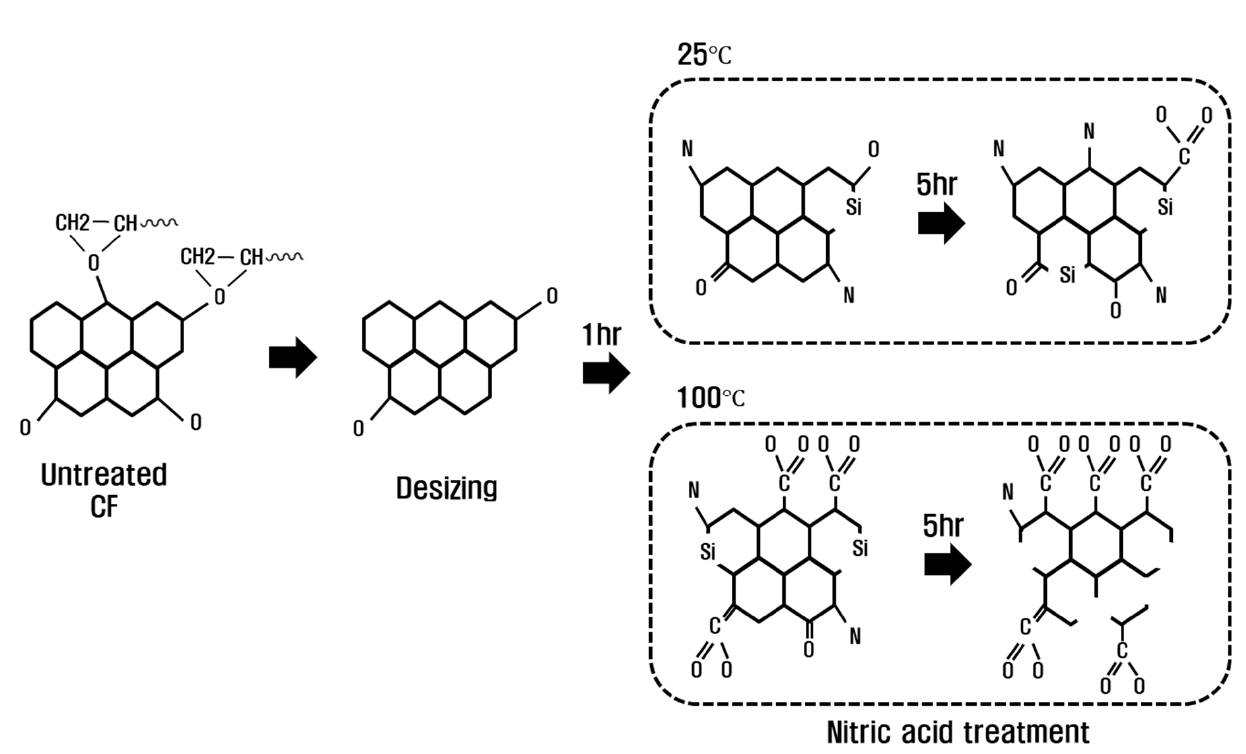
Figure 8. Schematic of the chemical reaction of carbon fiber according to chemical treatment temperature and treatment time.